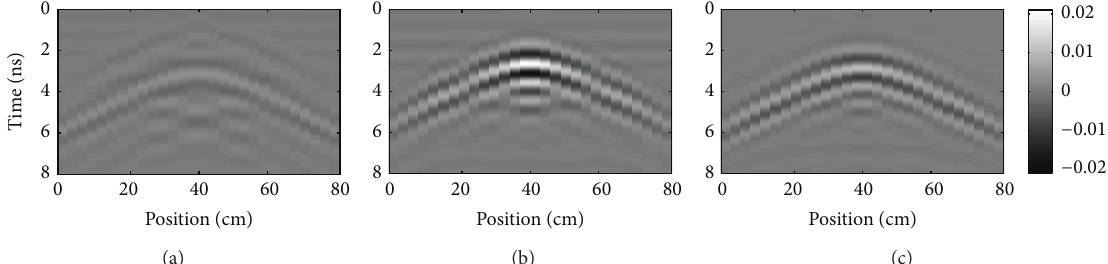
Figure 4: GPR B-scan synthetic radargrams for a vacuum cube of 10cm side, buried 10cm deep from an air/sand interface. Grey-scale received-signal amplitude in time versus longitudinal scanning position along 𝑥 , for three parallel lines at different 𝑦 : (a) line 1; (b) line 5; (c) line 8.